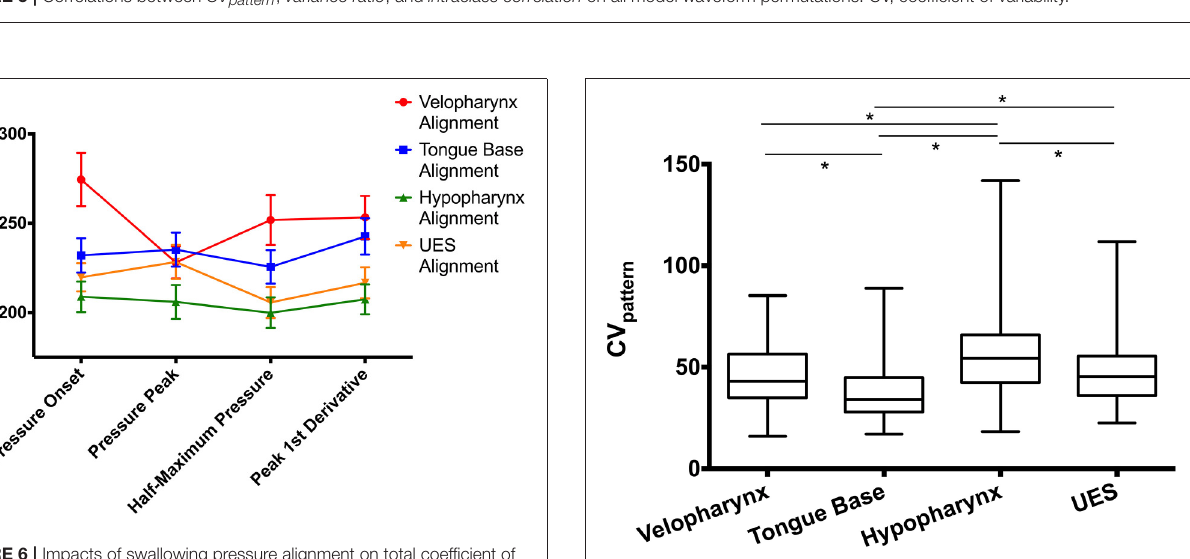
FIGURE 7 | Swallowing pressure variability by region. Swallowing pressures were significantly less variable in the tongue base than all other regions (* p < 0.0001). Pressure variability in the hypopharynx was greater than all other regions (* p ≤ 0.001). An illustration of swallowing pressure variability by region is in Figure 3 . CV, coefficient of variability; UES, upper esophageal